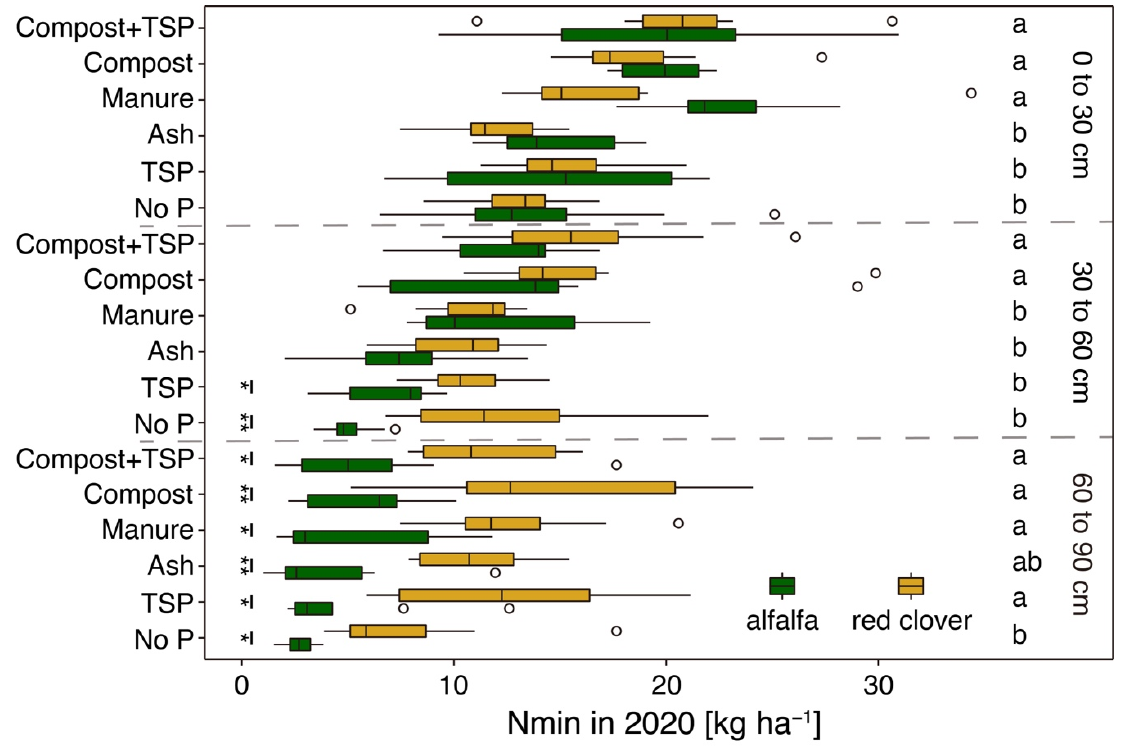
Figure 9. Mineral nitrogen (Nmin) content of soil samples taken in autumn 2020 in three soil depths (0 to 30, 30 to 60, and 60 to 90 cm) of the six studied treatments (no P, TSP, ash, manure, compost, and compost + TSP) with cultivation of alfalfa (green) and red clover (brown). Letters indicate a significant difference between treatments (based on average of plant species) within the same depth (Duncan’s new multiple range test with p < 0.05). Whiskers and asterisks indicate a significant interspecific difference between the respective treatments. Mean ± standard deviation (n = 8).